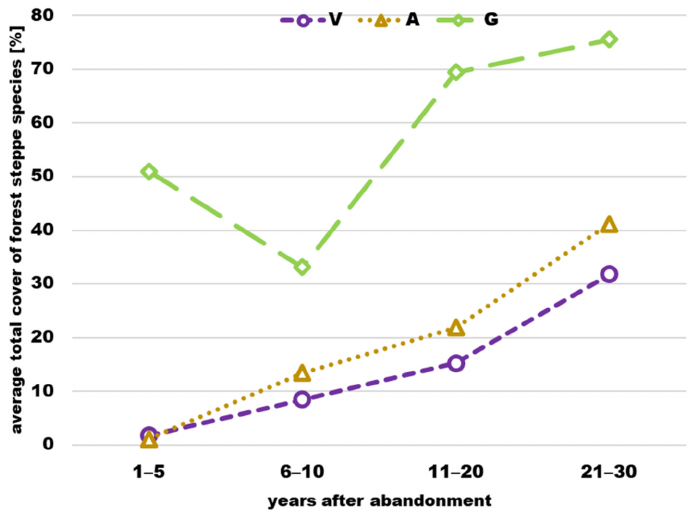
Figure 2. Changes in the average total cover of forest steppe species in different age groups of abandoned lands (V—vineyards, A—arable land, G—grasslands).